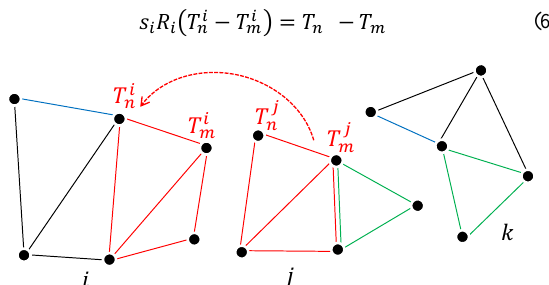
Figure 3. Camera positions in a target model are derived from corresponding base lines in rotated and scaled source models 𝑖 , 𝑗 and 𝑘 . For simplification only one camera pair is included in the